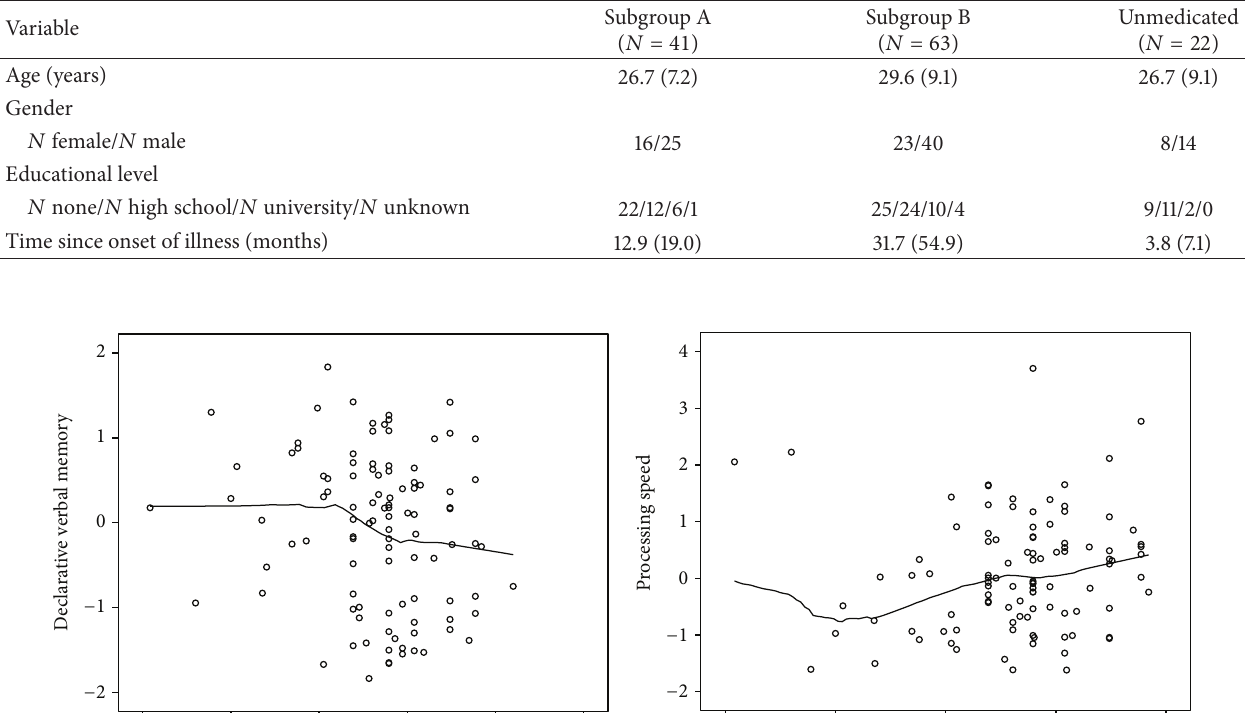
Table 4: Demographics of subgroup A, subgroup B, and the unmedicated patients group, results represented by mean value and standard deviation or absolute frequencies.